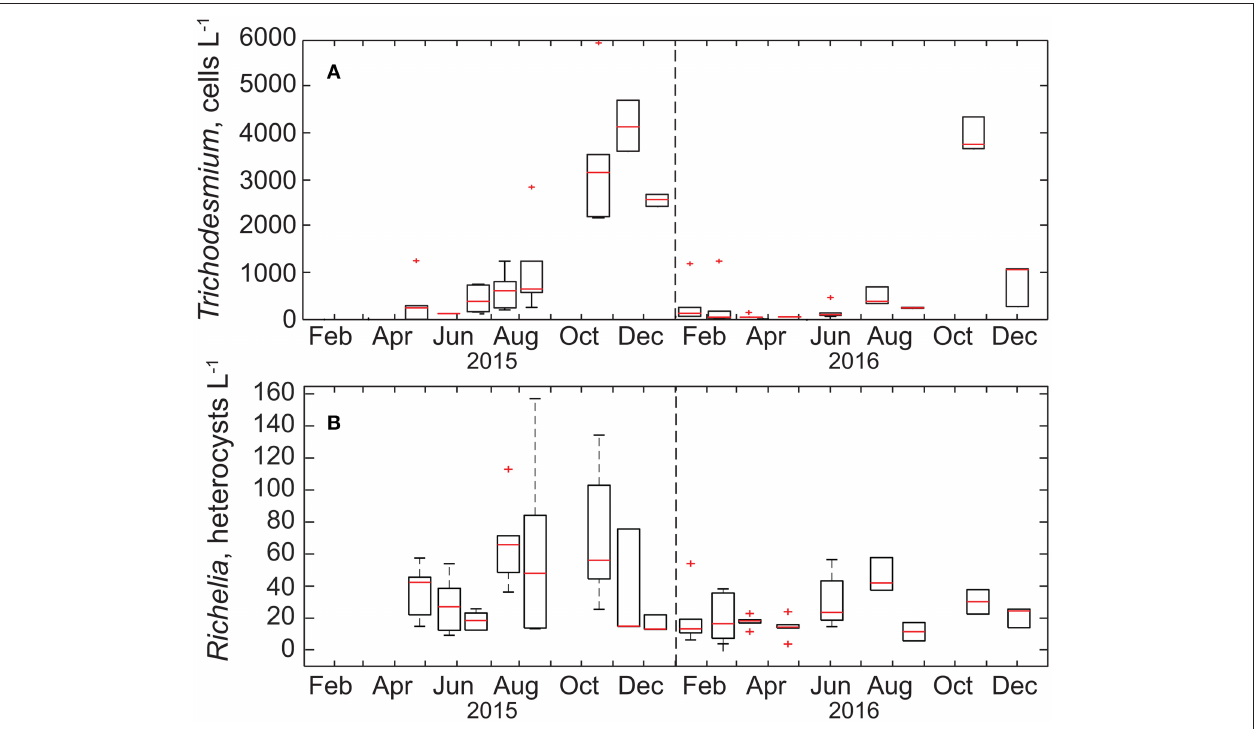
FIGURE 2 | Box-plots of the monthly time-series of (A) Trichodesmium cells and (B) Richelia + Calothrix heterocysts (the sum of free and diatom-associated heterocysts) in the upper 45m at Stn. ALOHA. The range of each box spans the 25th − 75th percentile of data for each month whereas whiskers are ± 2.7 standard deviations, the red line is the median, and plus symbols are outliers. The dashed vertical line in each panel is the demarcation between years.